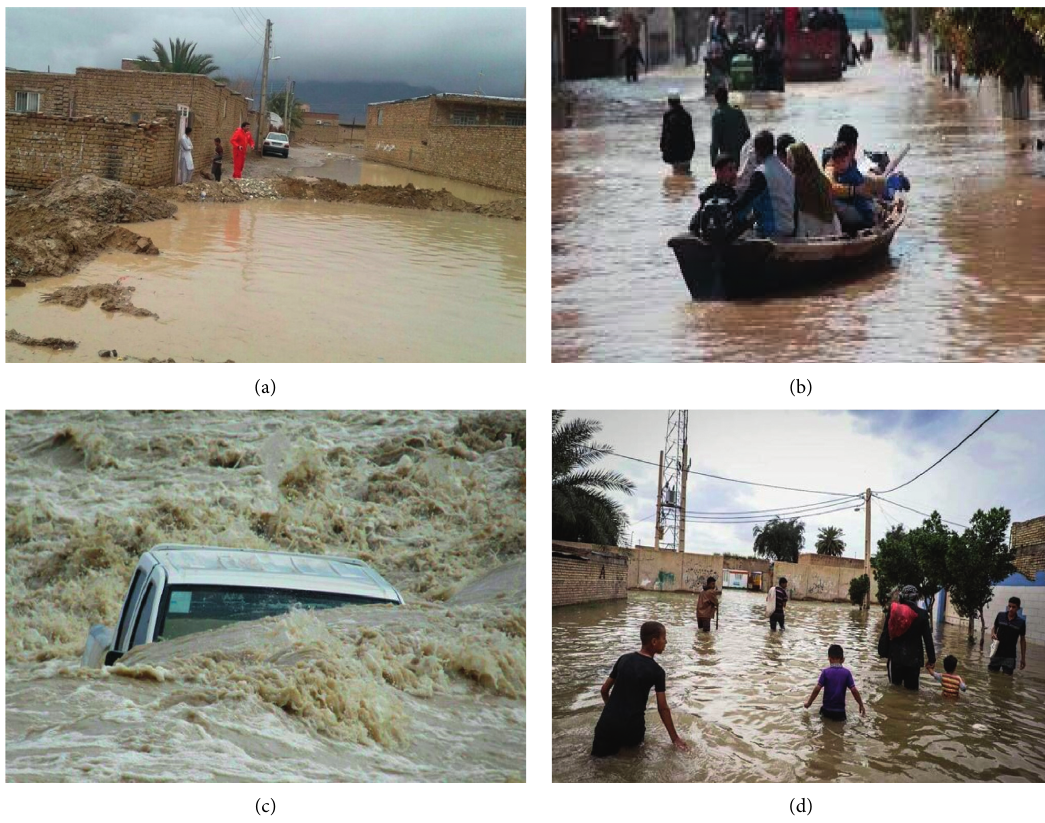
Figure 2: Photos of flood damage to Sistan and Baluchestan,